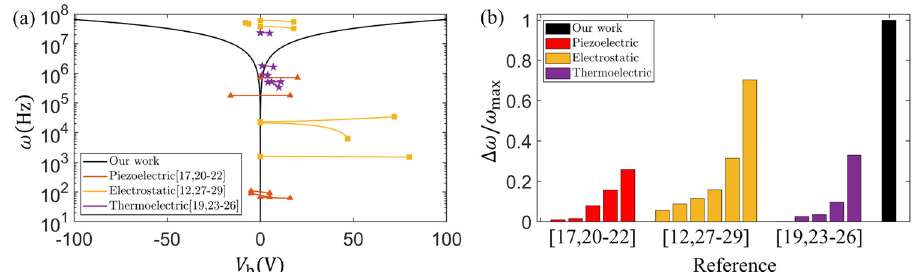
Fig. 2 Comparison between the ESL-resonator and conventional resonators. a Tunable resonant ranges for fi ve piezoelectric resonators 6,11 – 13 , six electrostatic resonators 18 – 21 , fi ve thermoelectric resonators 3,14 – 17 and that of the ESL-resonator (for W ¼ L ¼ 4 μ m ; s ¼ 2 μ m ; d ¼ 100nm ; ε r ¼ 3 : 9 ; ρ ¼ 2 : 16gcm (cid:1) 3 ; H ¼ 50nm : ) The solid lines of the ranges are given according to their respective theoretical or experimental relations, such as Eq. (3), or the literature 3,6,11 – 21 . b A comparison of the relative frequency tuning ranges of ð ω max – ω min Þ = ω max . Details in the Supplementary Note 3.